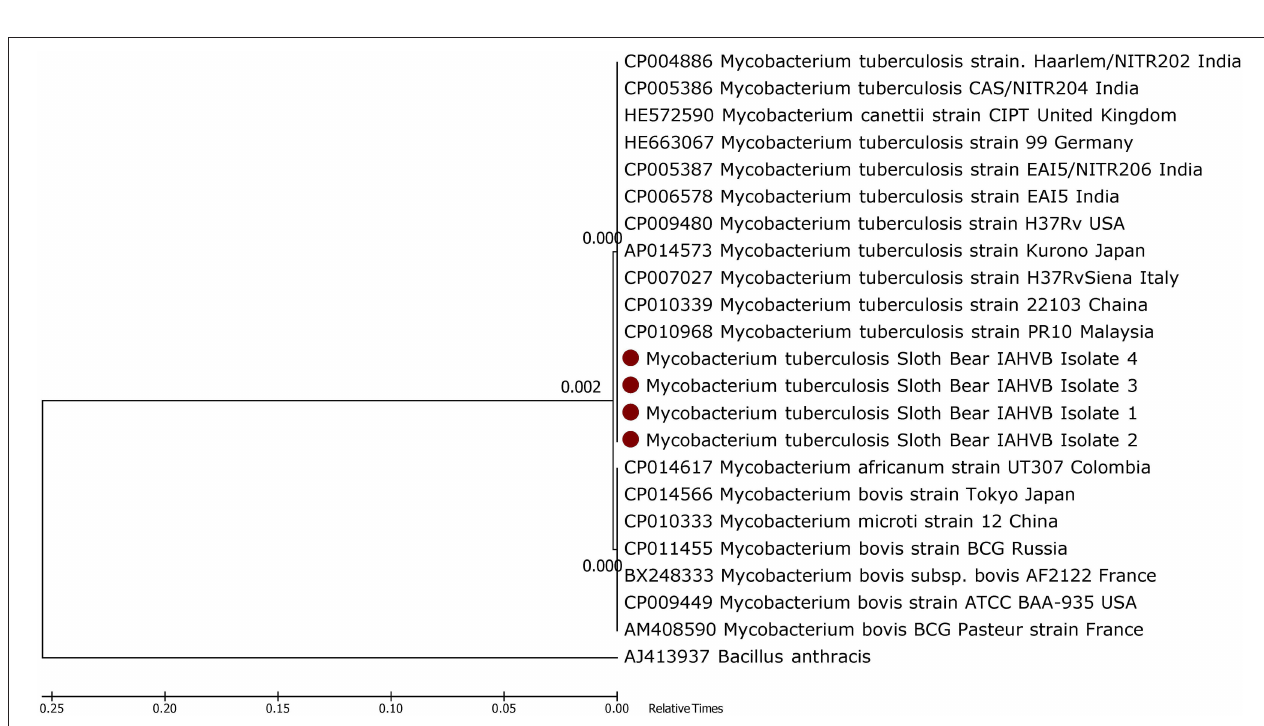
FIGURE 4 | Phylogenetic analysis of Mycobacterium tuberculosis isolates from sloth